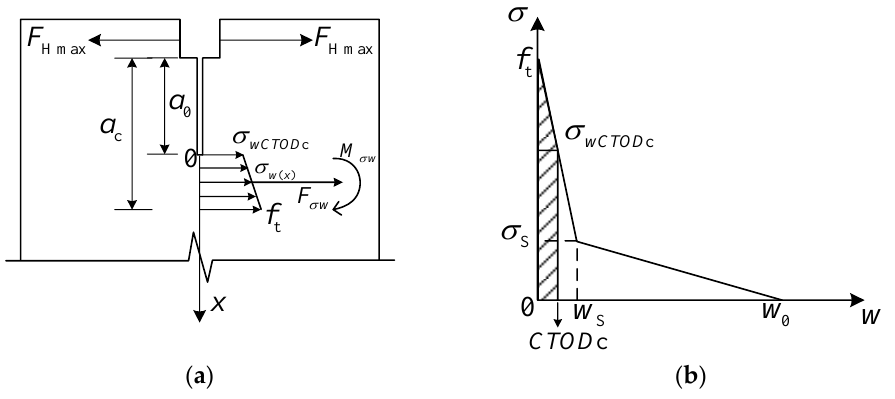
Figure 4. Case 1: ( a ) cohesive stress distribution; ( b ) softening curve. Substituting Equation (14) into (19), the cohesive stress distribution function in the